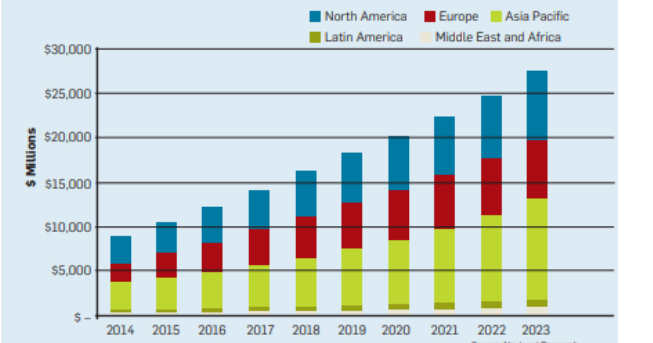
Figure 3. Smart city infrastructure investment by industry (2014-2023)